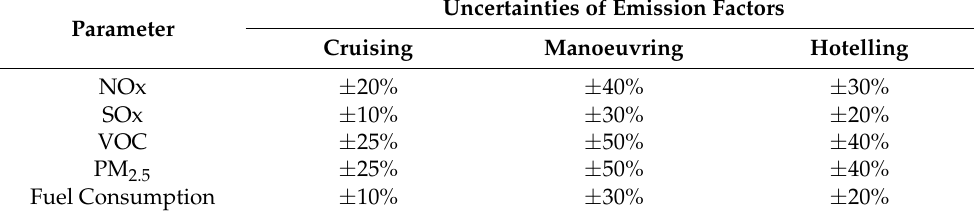
Table A5. Uncertainties of emission factors.